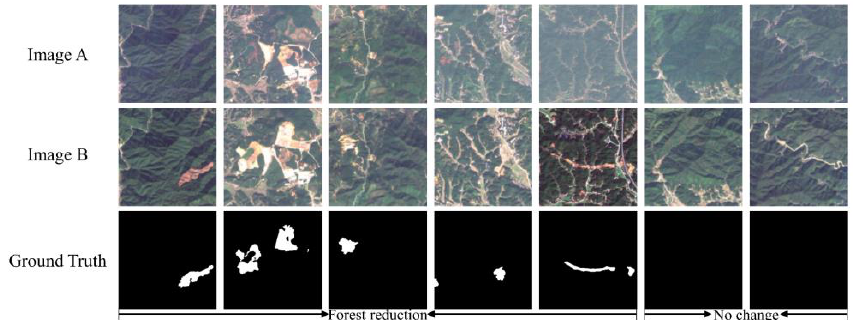
Figure 4. Selected cutting samples (256 × 256 pixels). In the label, white values of 255 indicate change, while black values of 0 indicate no change. The first five columns depict changes in forest reduction (column 1 represents forest reduction in mountainous areas, columns 2 – 4 depict forest reduction in urban areas, and column 5 shows forest reduction due to road construction), while the last two columns show examples of no change.